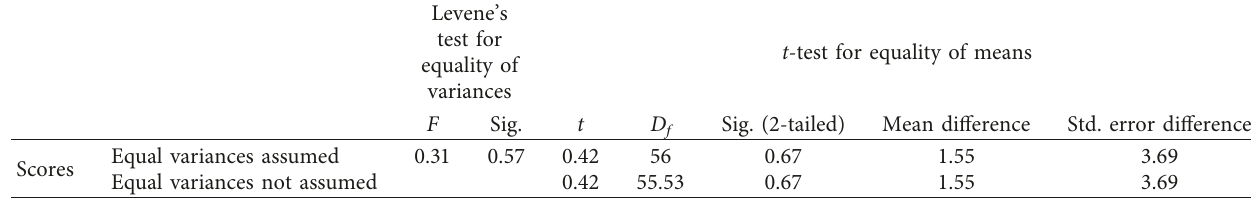
Table 6: Inferential statistics (motivation pretest of both groups).